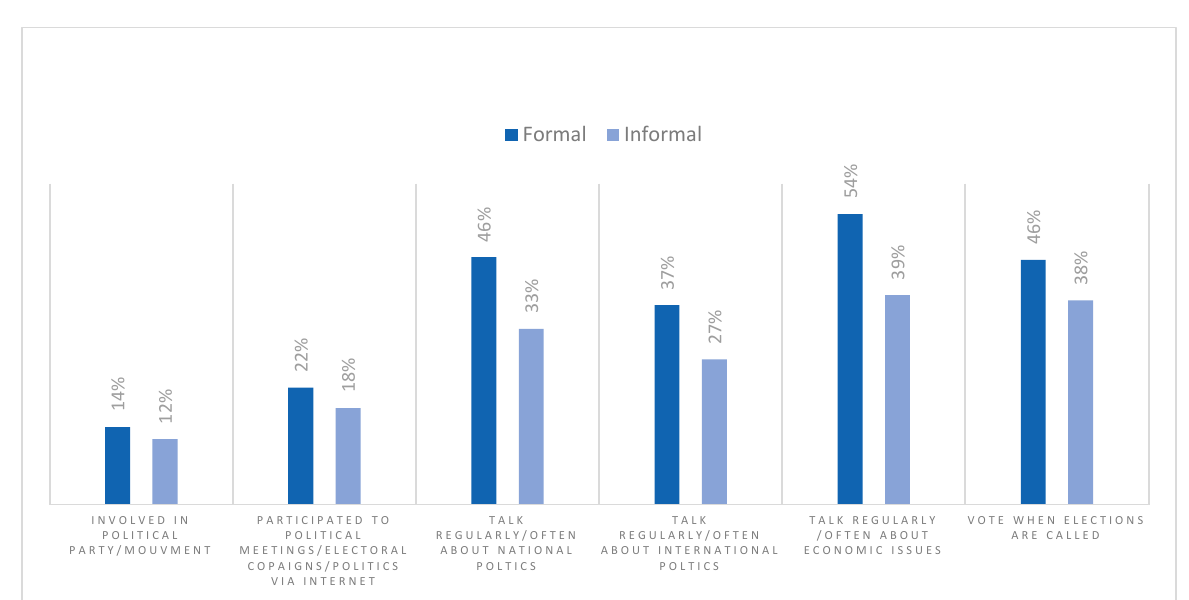
Figure 1. Political participation of formal and informal workers. Source: SAHWA survey—www.Sahwa.eu accessed on 10 June 2021.